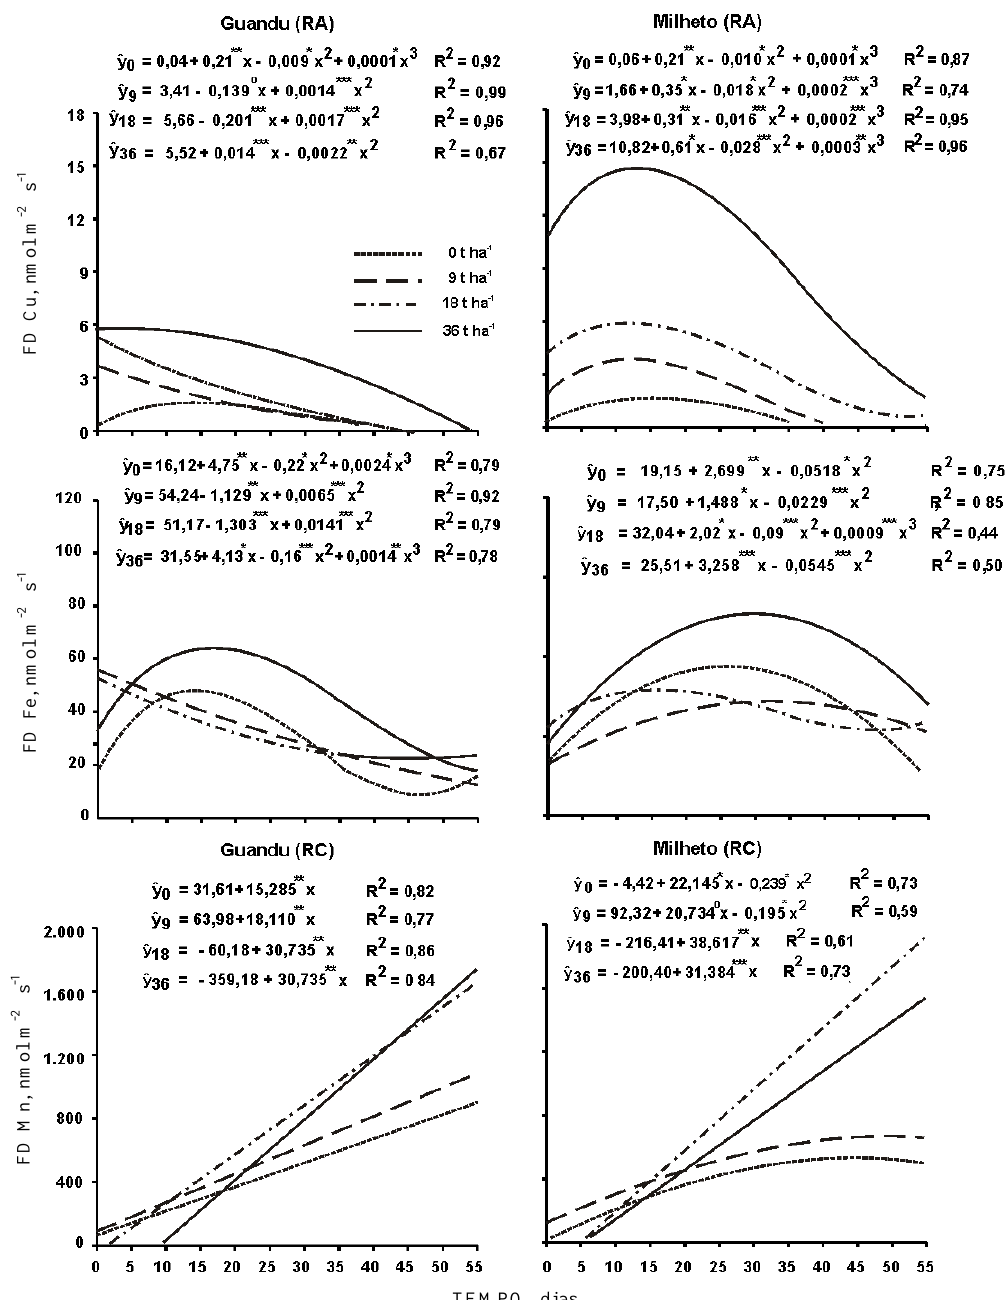
TEMPO, Figura 2. Fluxo difusivo de Cu e Fe para as resinas: aniônica (RA) e de Mn para a resina catiônica (RC) em Latossolo Vermelho argiloso influenciado pelo tempo de incubação e doses de feijão guandu e milheto. ns , º , * , ** , *** : não-significativo e significativos a 10, 5, 1 e 0,1 %, respectivamente.